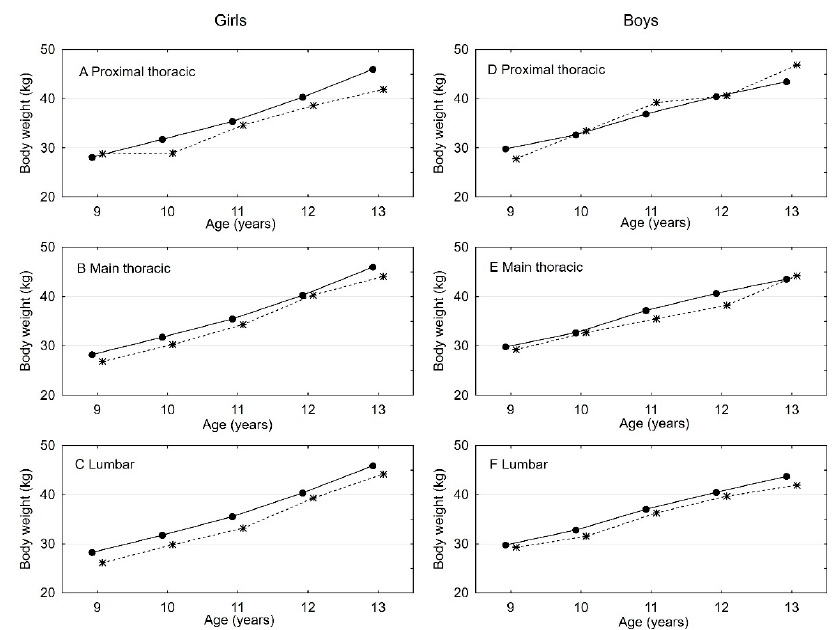
ff erences in ATR value with body weight.